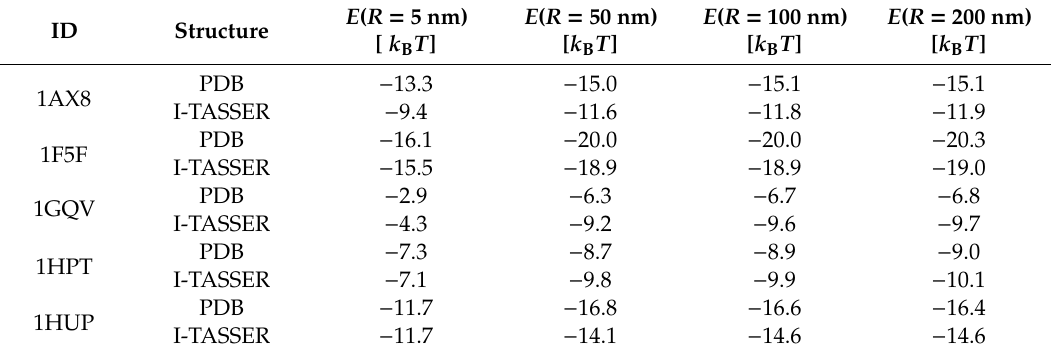
Table 3. Binding-free energy values of five sample proteins for their structures taken from the PDB and calculated using I-TASSER on for titanium dioxide NPs of radius 5, 50, 100, and 200